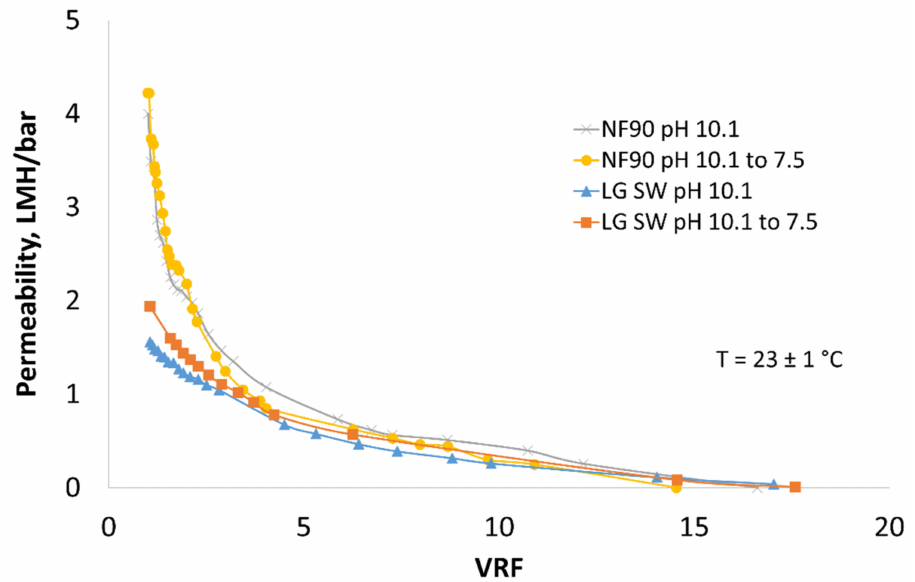
Figure 3. Concentration of pre-treated mine water using NF90, and LG SW precipitated using Na 2 CO 3 without and with pH adjustment.